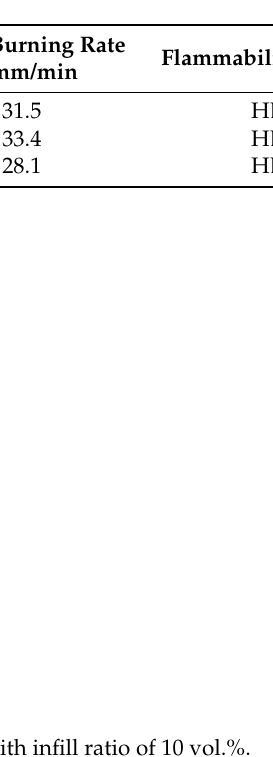
Table 3. Flammability of neat ABS sample and samples prepared with composite filaments of different filler content.